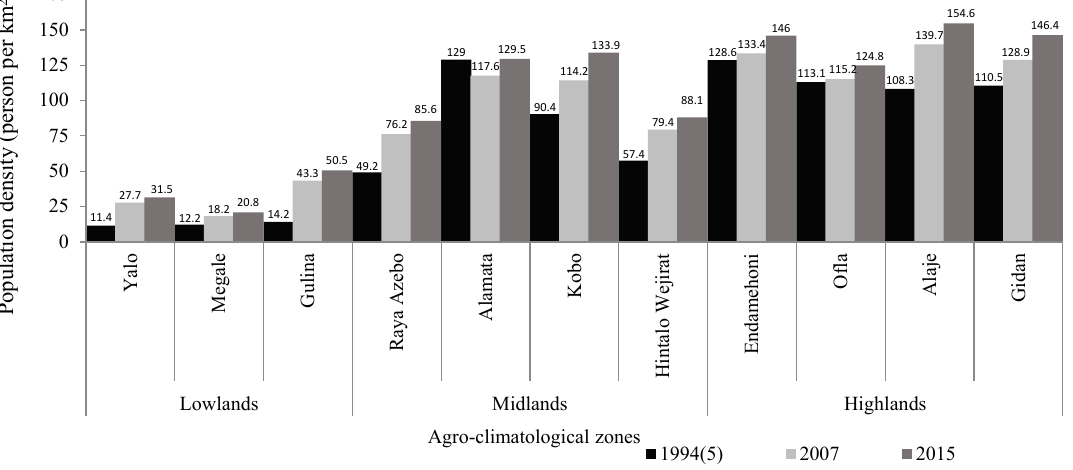
Figure 3. Population density of the study area.